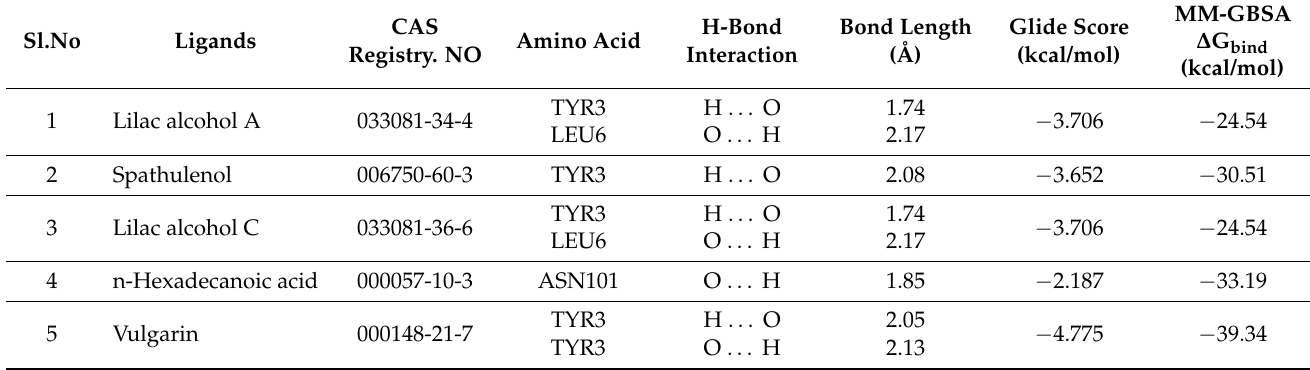
Table 4. Glide XP docking and MM/GBSA binding free energy ( ∆ G bind ) results for ligands with target protein MDR